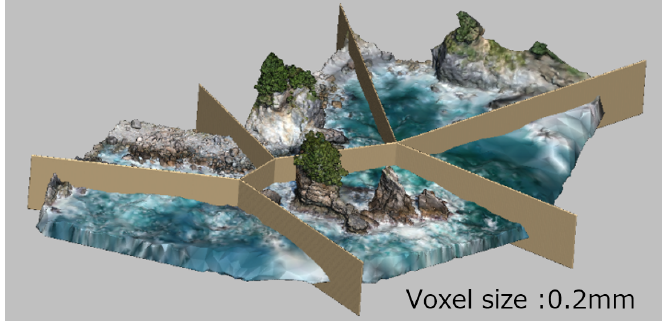
Figure 12. Model segmentation.